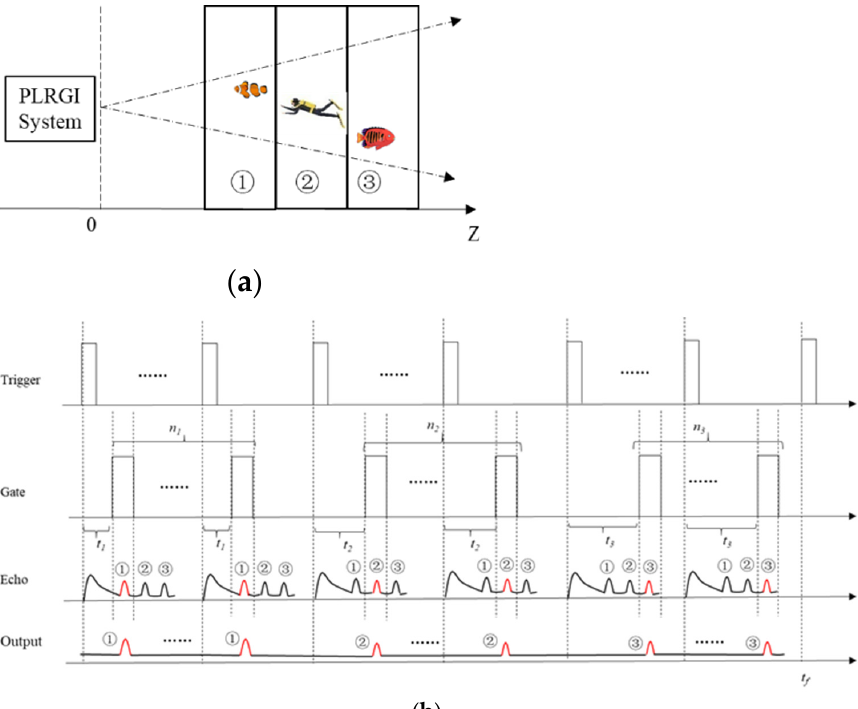
Figure 2. Description and Time sequence of the single slice. ( a ) Principle of PLRGI; ( b ) Time sequence of the single slice. Three slices are taken into consideration to present the principle of the MSI method as shown in Figure 3. In the system, a laser with a high pulse repetition frequency is utilized. The laser pulses in a video frame can be split into three groups, and each group corresponds to one slice. Each slice has its delay time and GW.